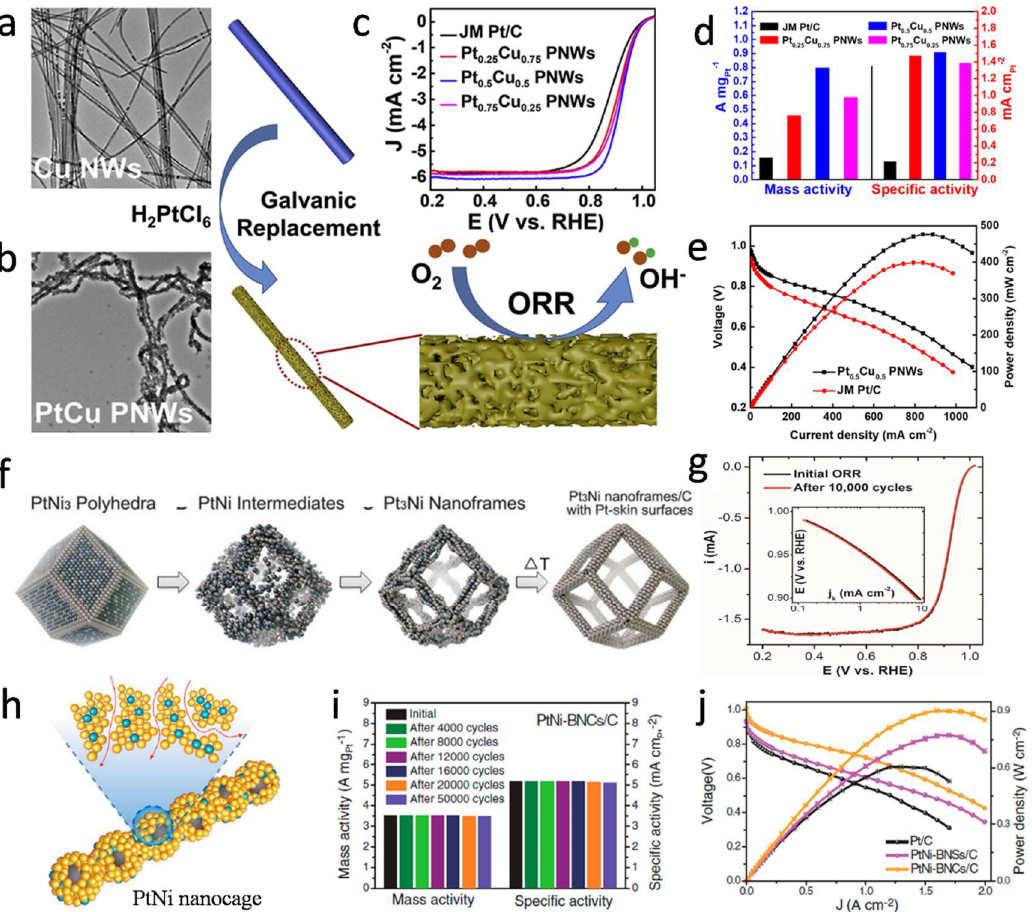
Figure 4. TEM images of ( a ) Cu NWs and ( b ) Pt 0.5 Cu 0.5 PNWs; ( c ) Linear sweep voltammetry (LSV) curves (O 2 -saturated 0.1 M HClO 4 solution at 10 mV · s − 1 and 1600 rpm); ( d ) Catalytic performance (0.9 V) of Pt 0.75 Cu 0.25 PNWs, Pt 0.5 Cu 0.5 PNWs, Pt 0.25 Cu 0.75 PNWs and JM Pt/C; ( e ) Power den- sity curves and polarization curves of Pt 0.5 Cu 0.5 PNWs and JM Pt/C (80 ◦ C and 100% humidity). Reproduced from Ref. [70] with permission from Elsevier, copyright 2021. ( f ) Pt-Ni nanoframes; ( g ) Tafel plots and LSV curves of Pt 3 Ni nanoframes before and after accelerated degradation test (ADT). Reproduced from Ref. [73] with permission from Science, copyright 2014. ( h ) Bunched Pt-Ni hollow nanocages; ( i ) ADT of bunched Pt-Ni hollow nanocages for 50,000 cycles; ( j ) H 2 -air PEMFC polarization plots. Reproduced from Ref. [96] with permission from Science, copyright